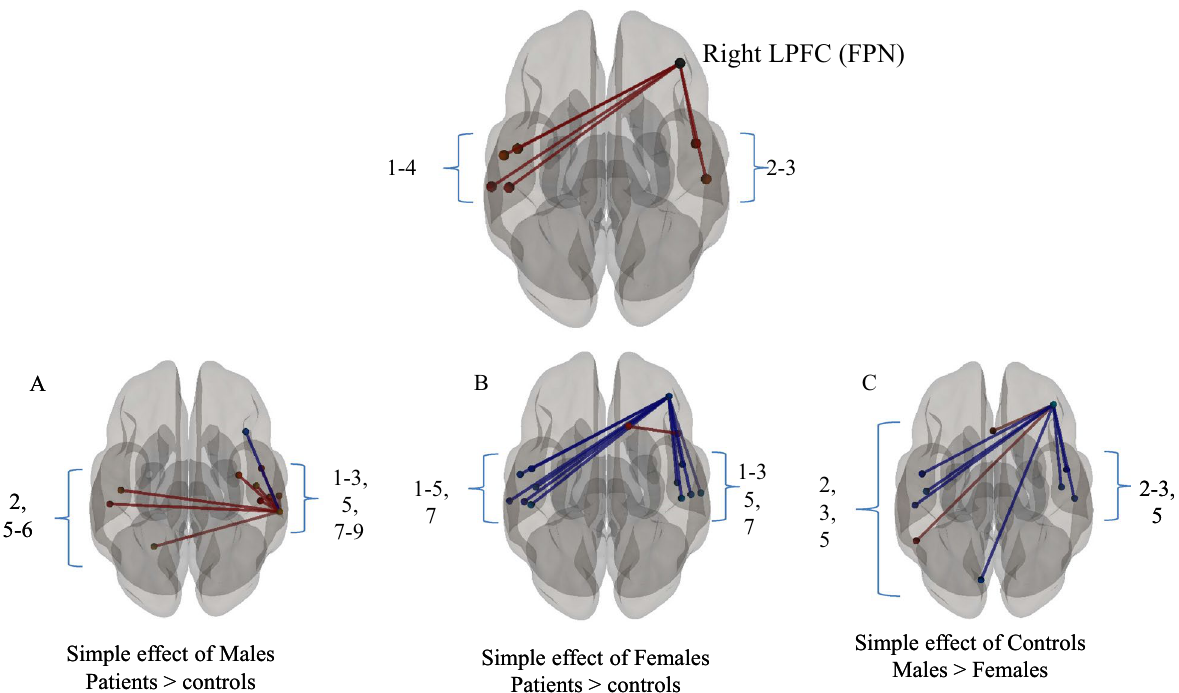
Figure 2. - The interaction effect of injury (males > females) × injury (concussed > controls) as well as the simple effects of ( A ) males, ( B ) females and ( C ) controls. The images are displayed using neurological convention. 1. Superior Temporal Gyrus, Posterior division; 2. Planum Temporale; 3. Central Opercular Cortex; 4; Lateral sensorimotor network; 5. Heschl’s Gyrus; 6. Cerebellar lobule V1; 7. Parietal Opercular Cortex; 8. Pre Central Gyrus; 9. Middle Frontal Gyrus; 10. Subcallosal Cortex; 11. Inferior Temporal Gyrus, temporooccipital part; 12. Cuneal Cortex. Image generated using CONN, an open- source computational platform available at https ://web.conn-toolb